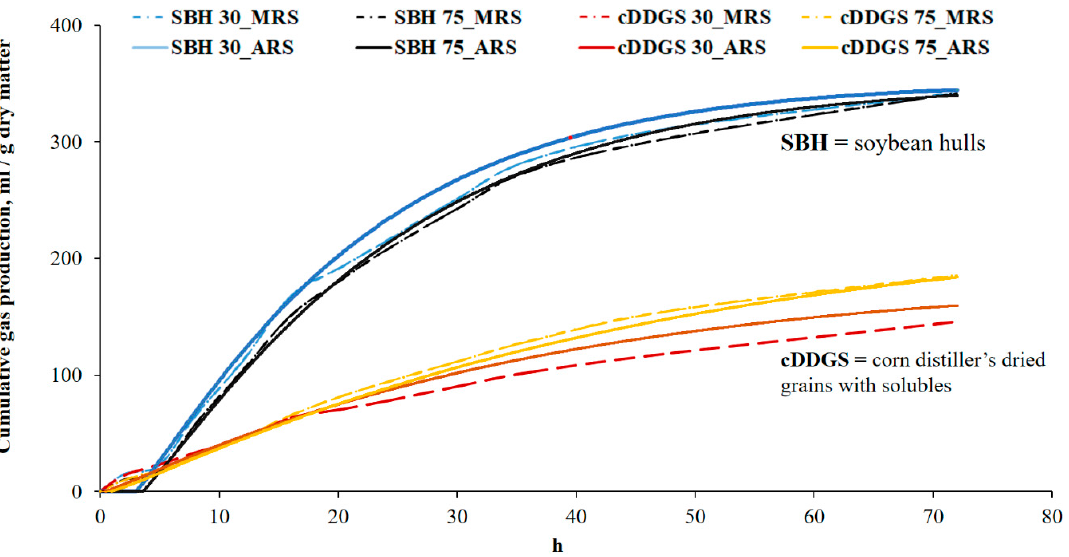
Figure 1. Gas accumulation curves of two ingredients (soybean hulls = SBH; and corn dried distiller’s grains with solubles = DDGS) and inoculum volume (30 and 75 mL) incubated either in automatic gas production recording system (ARS) or manual gas production recording system (MRS) during 72 h.